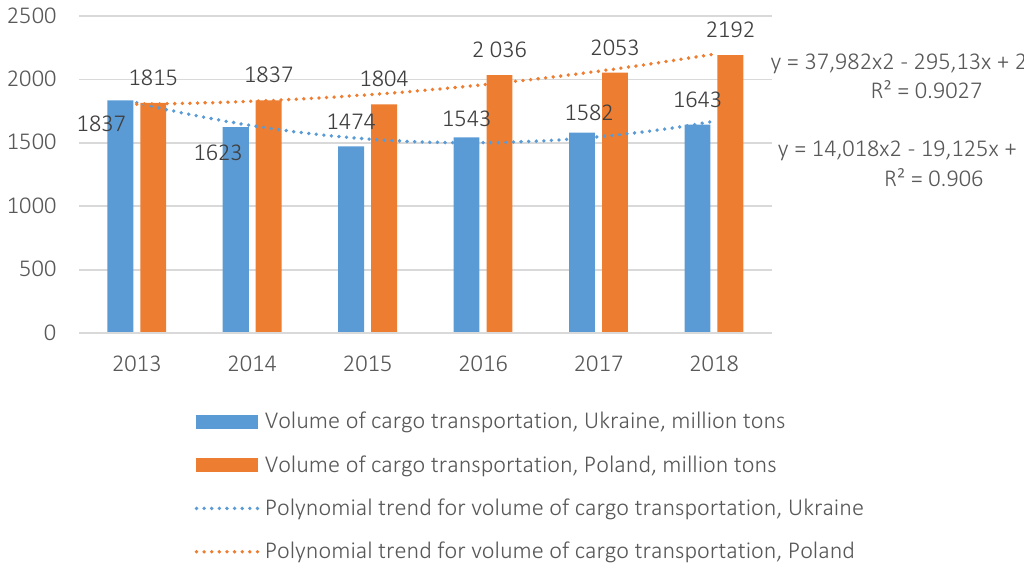
Figure 5. The dynamics of volume of cargo transportation in 2013–2018 in Ukraine and Poland, million tons